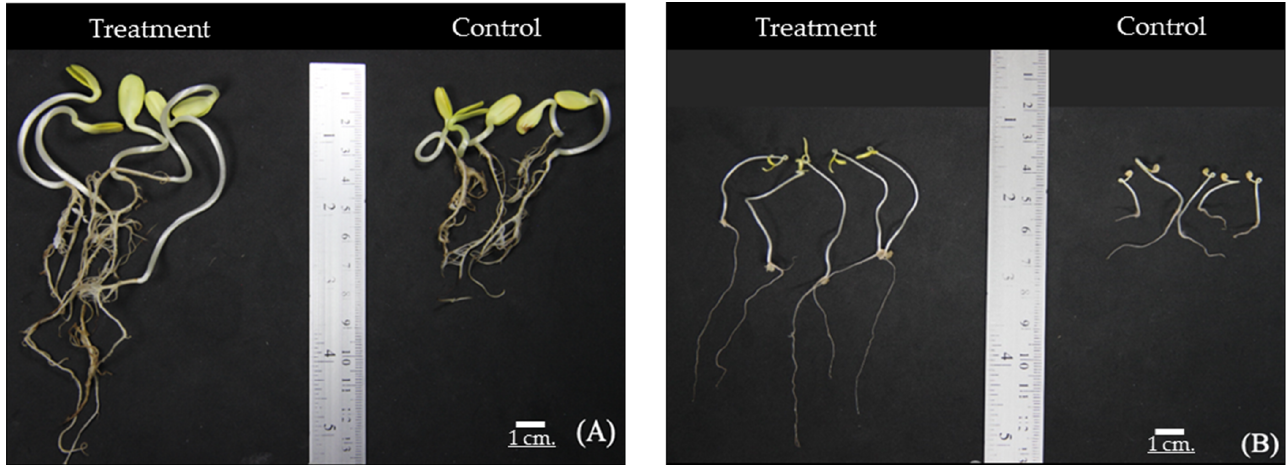
Figure 6. Effect of seed treatment with viable cells of selected bacterial endophyte ( Curtobacterium citreum P-5.19) on shoot and root growth of sunflower ( A ) and tomato ( B ) seedlings. Photographs showing higher shoot and root growth in bacteria-treated seedlings compared to untreated seedlings. Photographs were taken at day 5 after the treated seeds were placed in Petri dishes for germination.